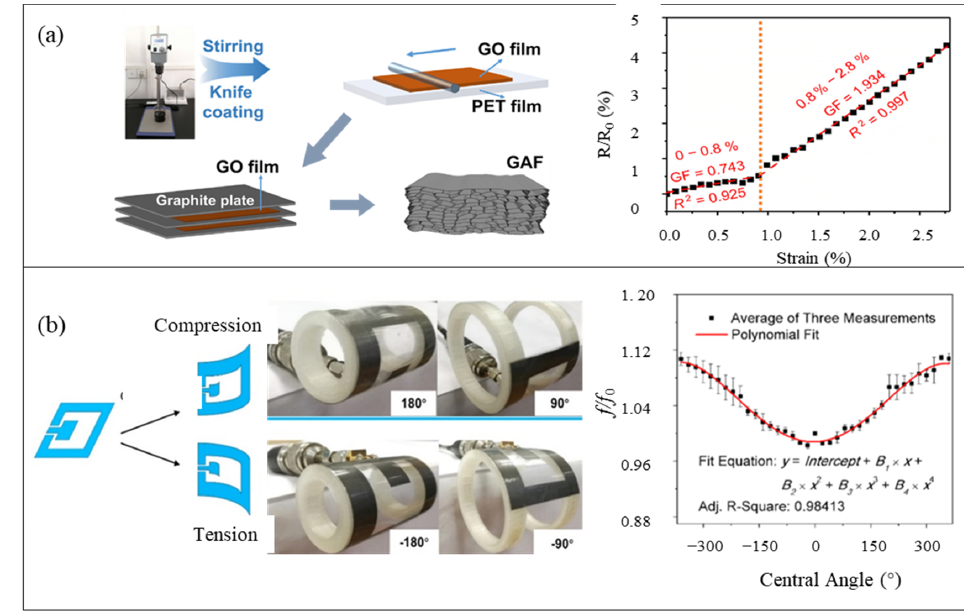
Figure 13. Flexible strain sensor based on pure macro-graphene: ( a ) fabrication of the GAF [160] (Copyright 2016, Elsevier Ltd.); ( b ) GAF antenna-based wireless strain sensor for measuring compression and tension [162] (Copyright 2020, American Chemical Society).